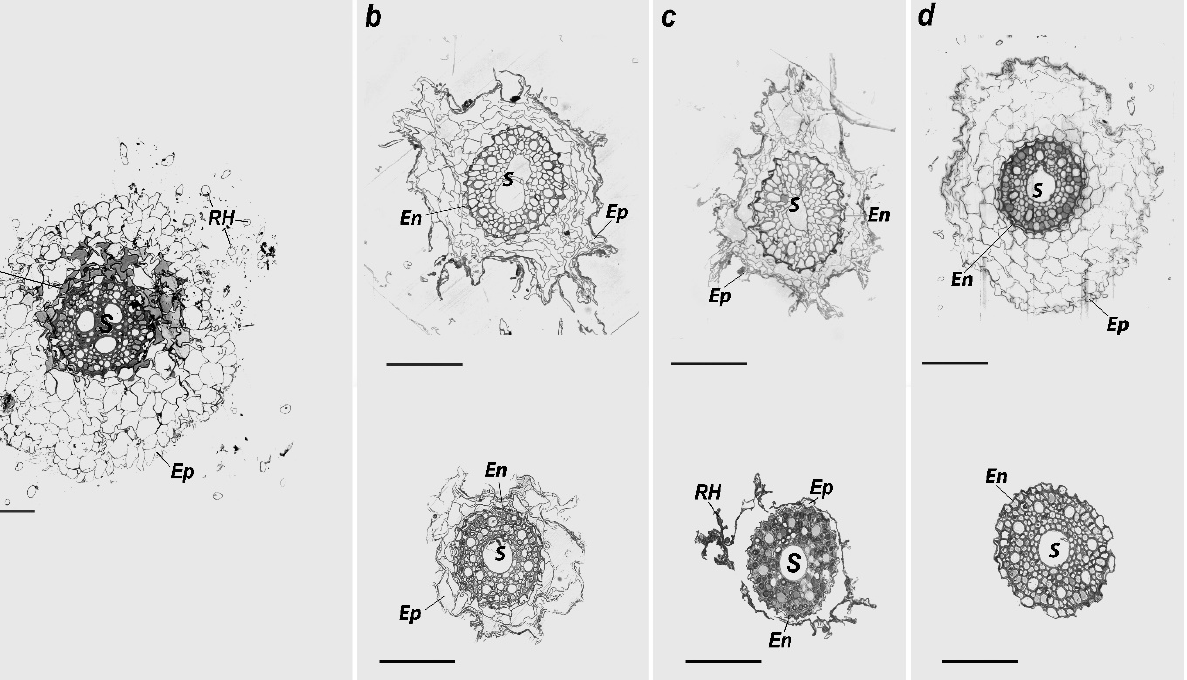
Figure 3. The H. vulgare root cross-section: ( a )—control, ( b )—treatment with Zn 440 mg/kg (top), and Zn 1100 mg/kg (bottom) ( с )—treatment with Cd 4 mg/kg (top) and Cd 10 mg/kg (bottom), ( d )—treatment with combined contamination by Zn 440 mg/kg + Cd 4 mg/kg (top) and Zn 1100 mg/kg + Cd 10 mg/kg (bottom). RH—root hairs, Ep—epidermis, En—endodermis, S—central cylinder. Scale of the section was 100 µm.